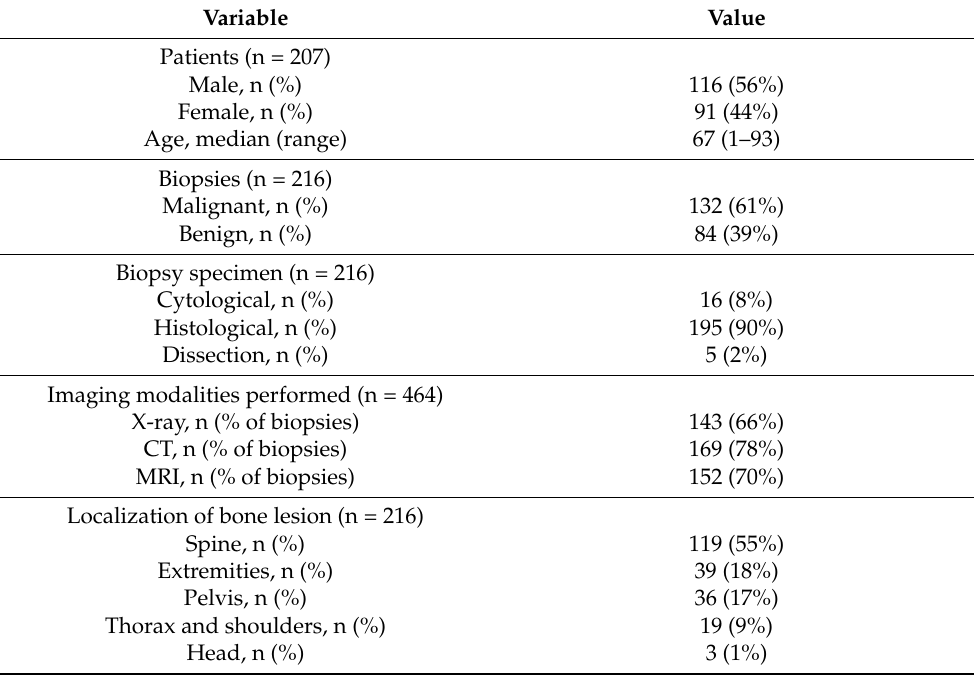
Table 1. Baseline demographics.